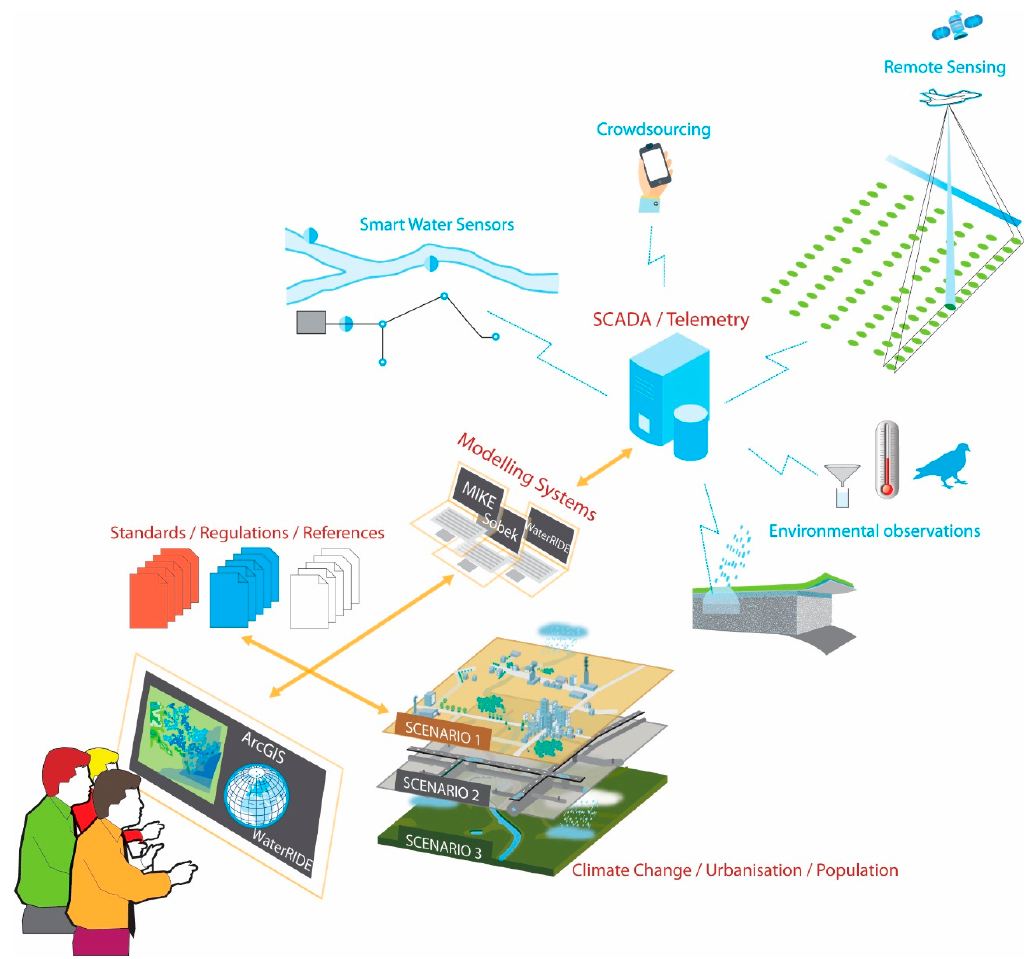
Figure 1. Illustration of hydroinformatics environments which have the primary aim of enabling stakeholders to co ‐ develop their water ‐ related solutions in a holistic way.